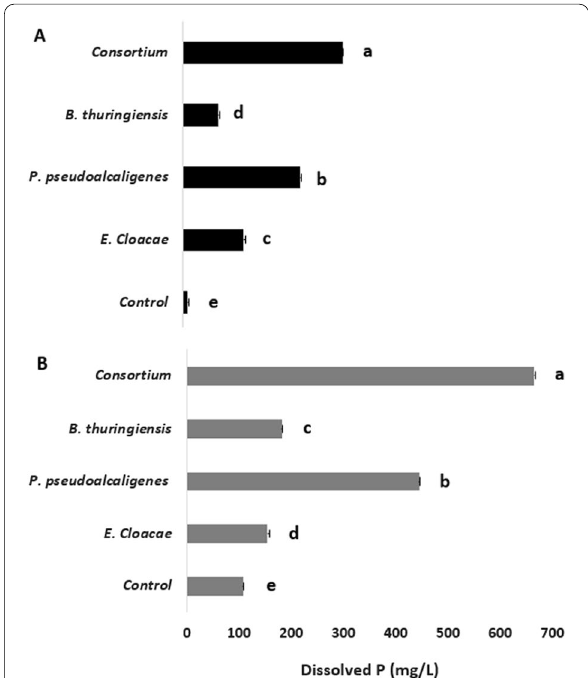
Fig. 1 Mean phosphate solubilization of individual bacteria isolates and consortium incubated in NBRIP phytin and calcium phosphate solutions. Samples were analyzed by coupled plasma-optical emission spectrometer. Figure shows dissolved P (mg L − 1 ) released from ( A ) calcium phosphate and ( B ) phytin media. Different letters indicate significant differences ( p < 0.05) and error bars the standard error of the mean